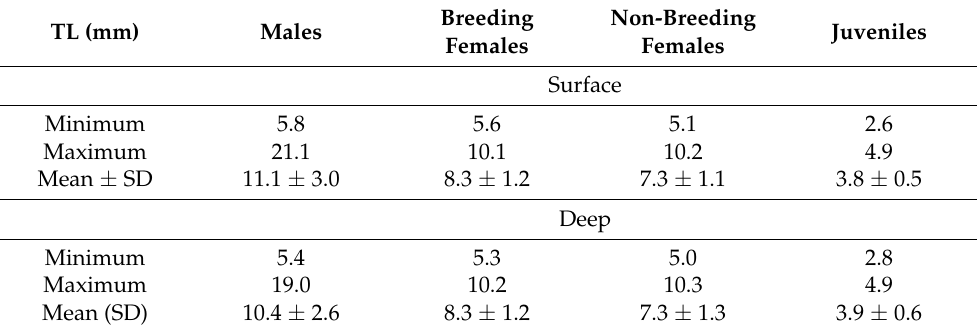
Table 1. Minimum, maximum and mean ( ± SD) total length values (mm) of the different demographic categories from the surface and deep population of Caprella scaura from the Pagasitikos Gulf. TL